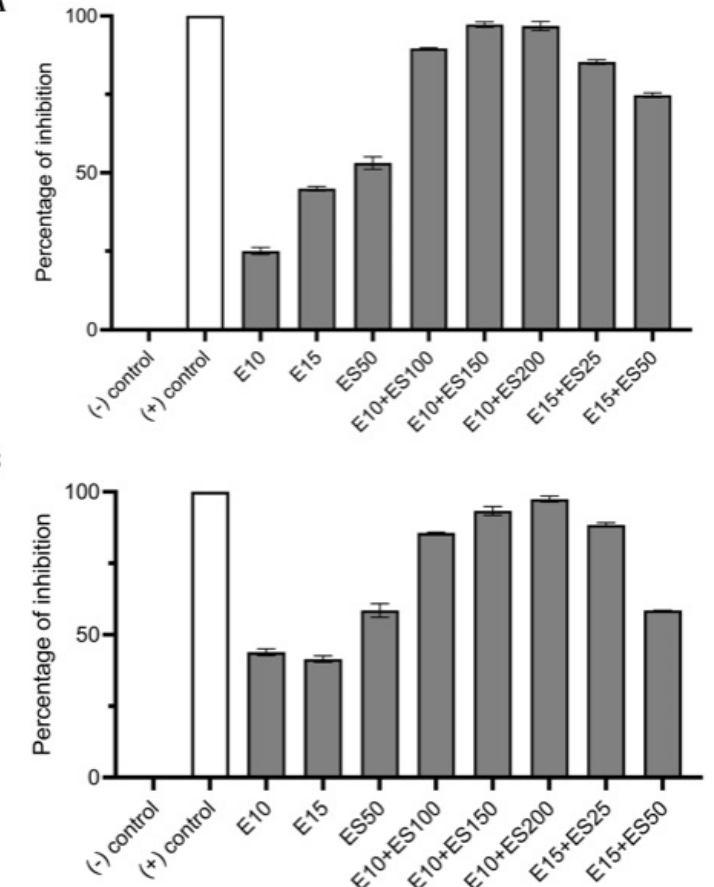
Figure 1. Effect of single and combined treatments of erythromycin (E) and EGCG-S (ES) on biofilm formation in E. coli . The percentage of inhibition for ( A ) crystal violet assay and ( B ) Resazurin assay were calculated from respective measurement. (-) control: phosphate buffer saline (PBS) buffer; (+) control: 10% bleach. Experiments were repeated in triplicates. Means are shown with SD. The percentage of inhibition with different concentrations of erythromycin and EGCG-S indicated that E10+ES200 inhibits E. coli biofilm formation most effectively.